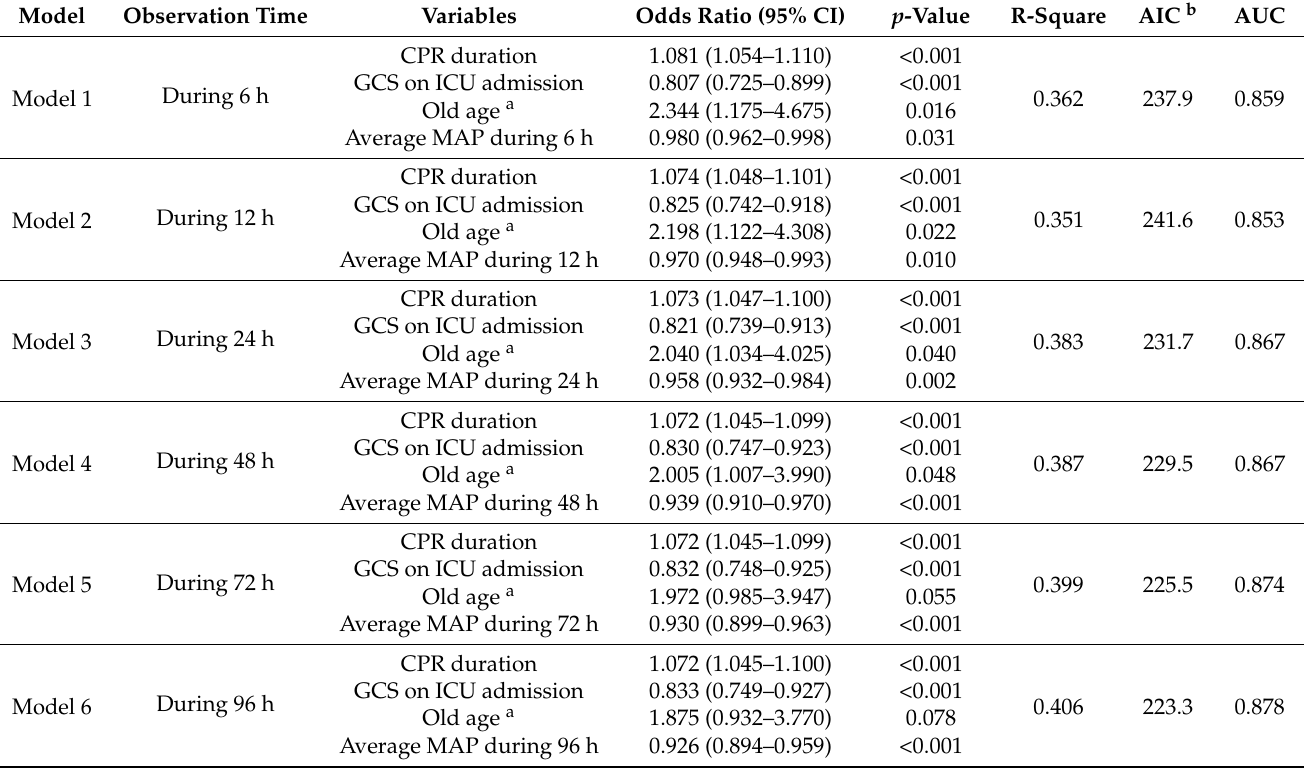
Table 2. Multiple logistic regression models according to the observation